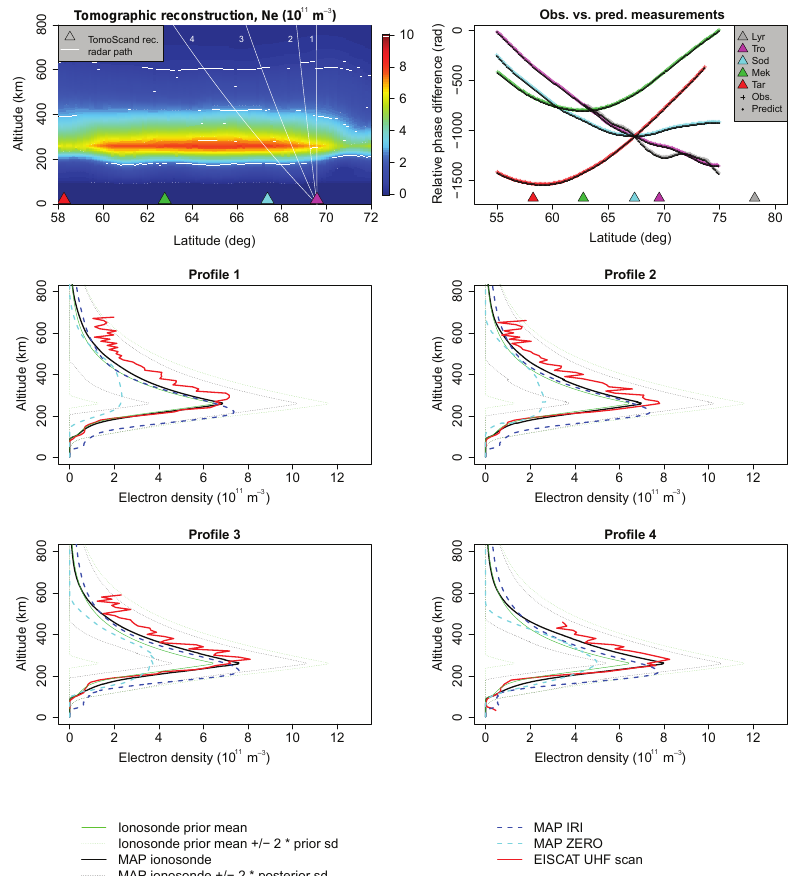
Figure 4. Reconstruction, phase curves and profile comparisons for Overflight II starting on 3 November 2015 at 13:50UTC.